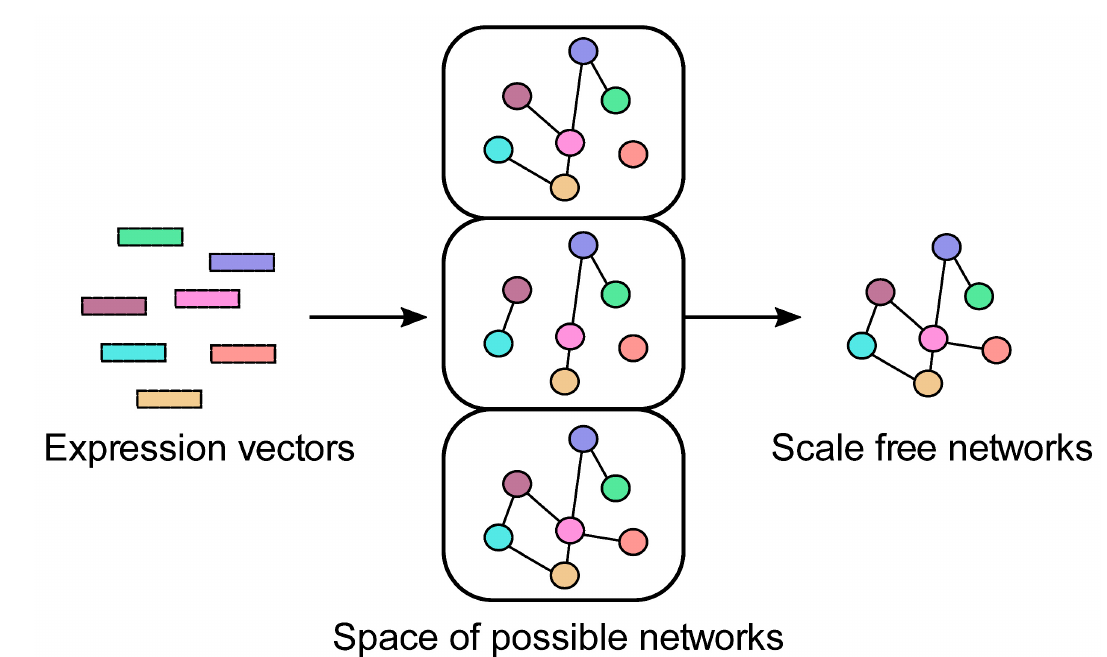
Figure 2. Schematic overview of the network (re)construction process.